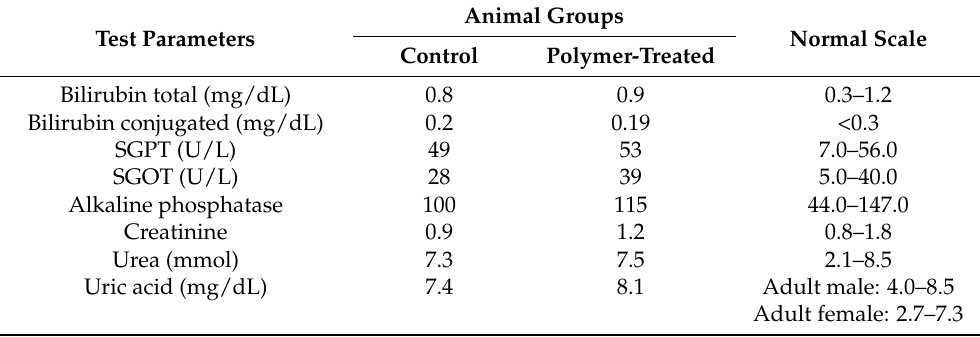
Table 2. Liver and renal function parameters in control and after induction of Ocicum